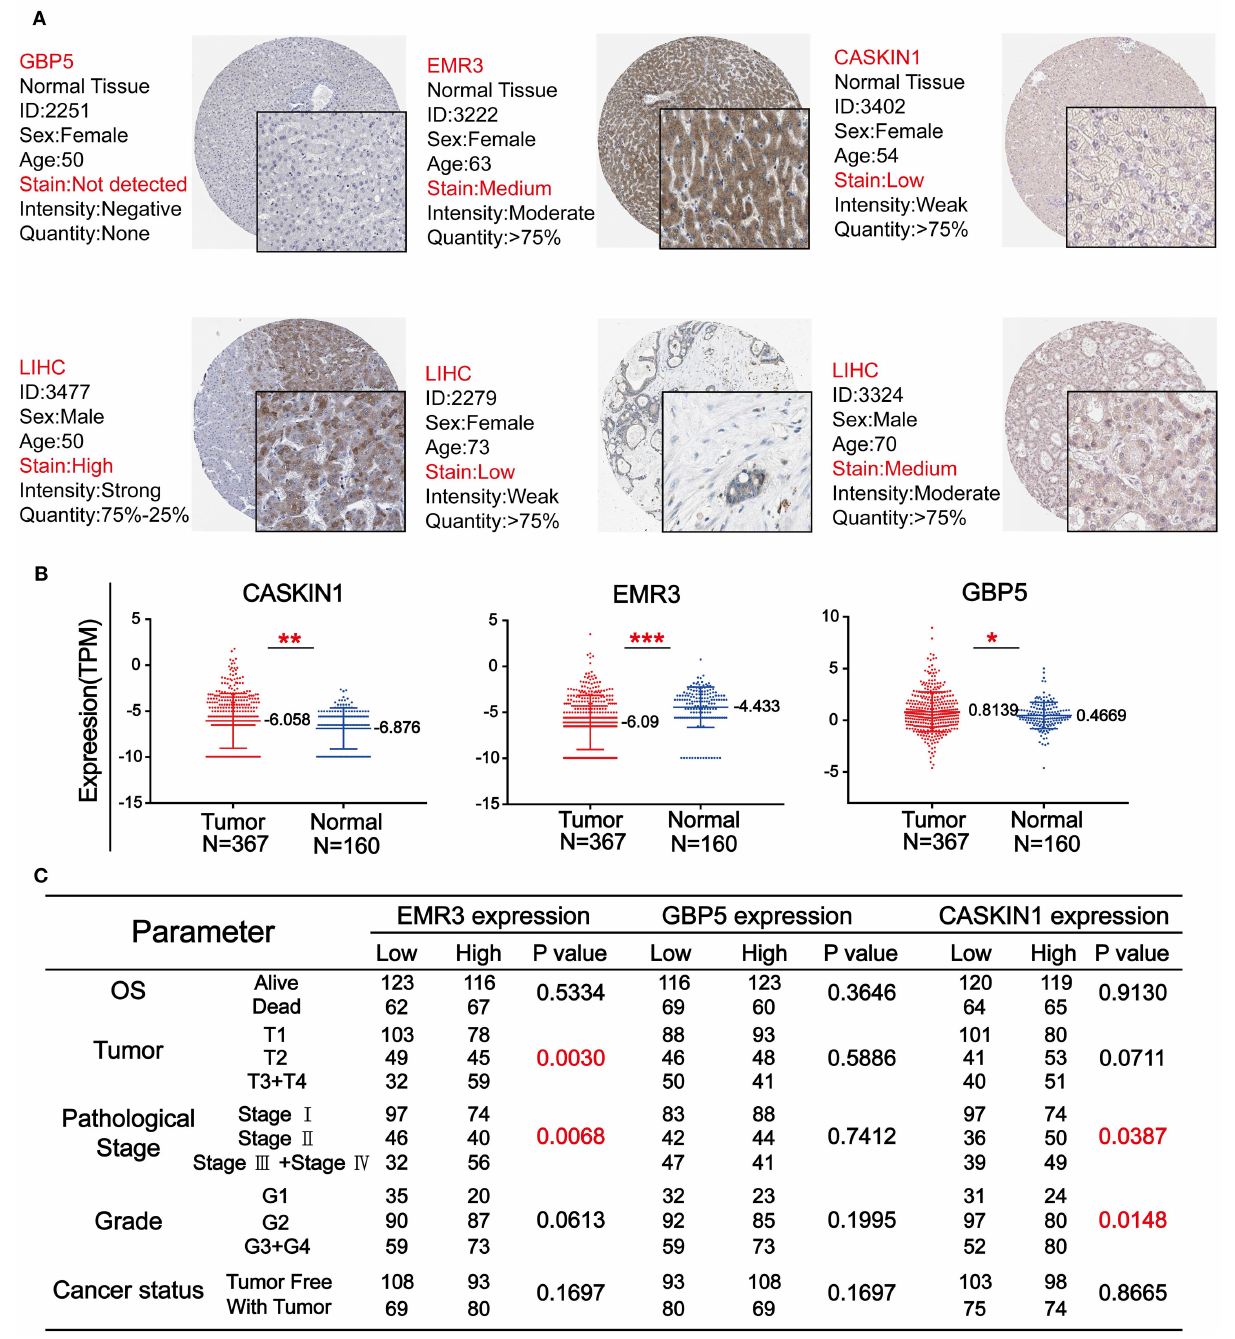
Frontiers in Immunology |